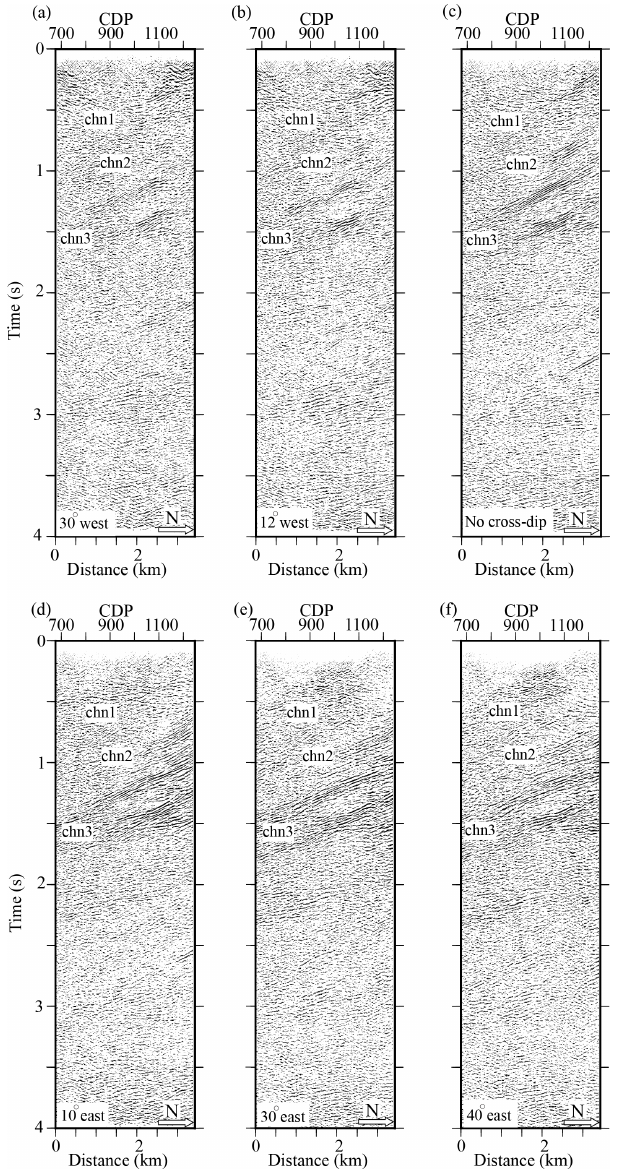
Figure 7. CDMO analysis for the north survey along Sect. 2 (see Fig. 4 for the location of the section). (a) DMO-corrected stacked section with cross-dip element of 30 ◦ to the west applied. (b) DMO- corrected stacked section with cross-dip element of 12 ◦ to the west applied. (c) DMO-corrected stacked section with no cross-dip el- ement applied. (d) DMO-corrected stacked section with cross-dip element of 10 ◦ to the east applied. (e) DMO-corrected stacked sec- tion with cross-dip element of 30 ◦ to the east applied. (f) DMO- corrected stacked section with cross-dip element of 40 ◦ to the east applied. See text for the interpretation of marked